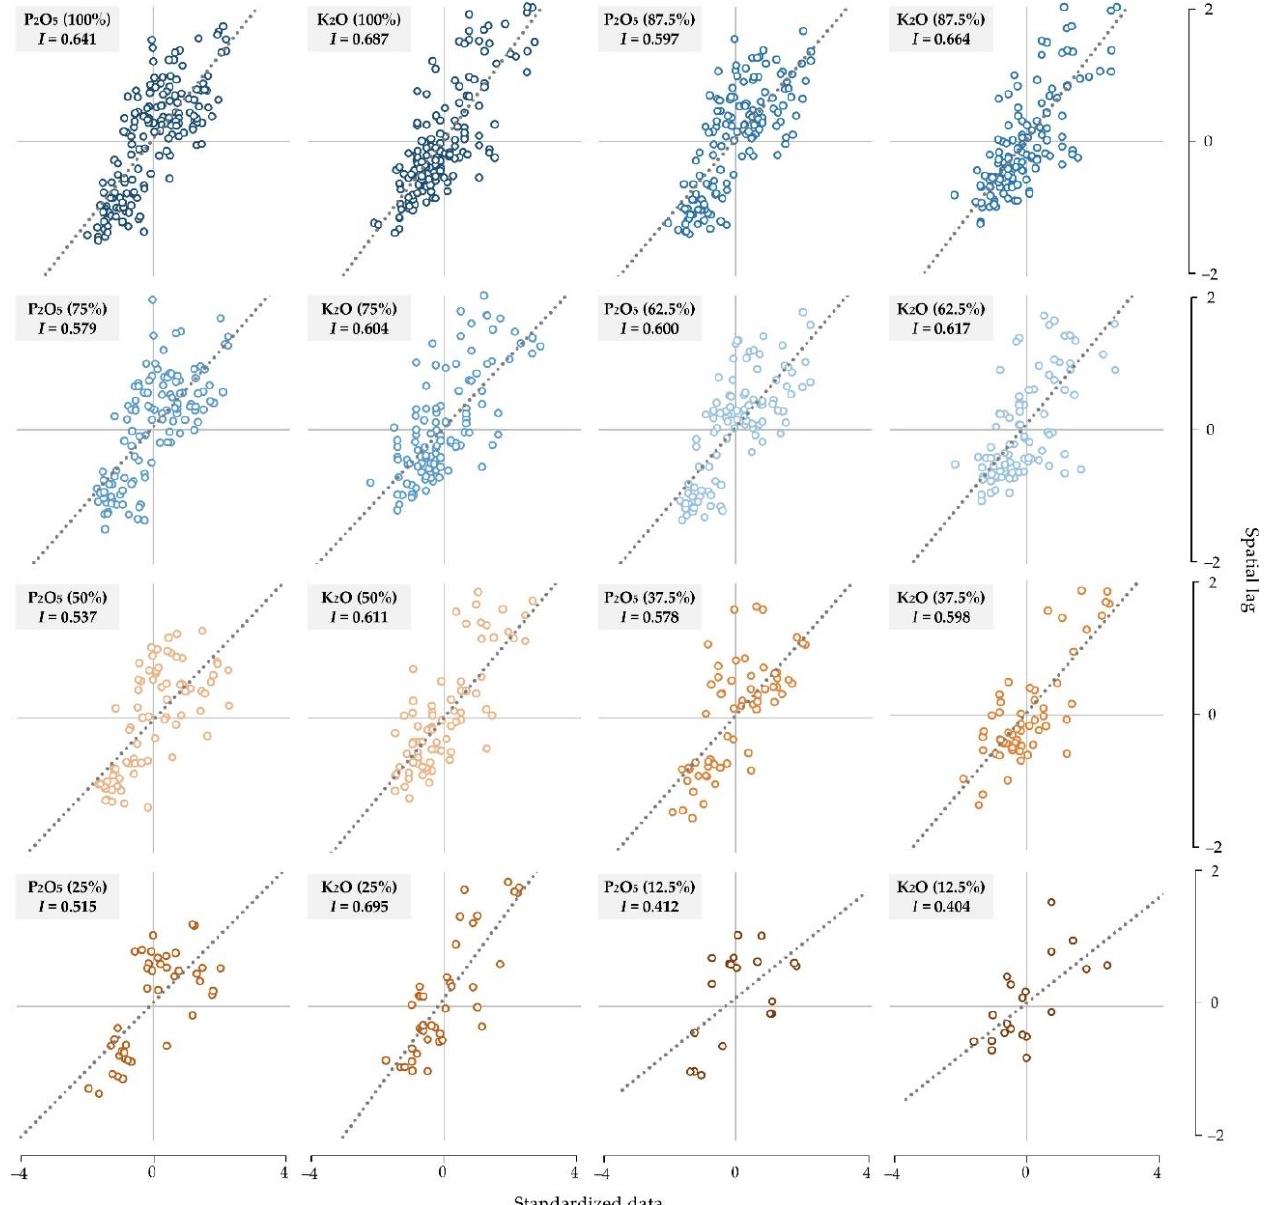
Moran’s I values of all subsets revealed a positive, moderately-high spatial autocorre- lation (Figure 4). A stable Moran’s I was retained while lowering soil sample percentages by up to 25% of the original datasets, the values dropping noticeably for the 12.5% subset. Both soil chemical properties resulted in values of over 0.500 for these subsets, while K 2 O resulted in a slightly higher spatial autocorrelation than P 2 O 5 values. The distance of the spatial autocorrelation per subset was analyzed by correlograms, showing stable value and a noticeable increase for the 25% and 12.5% subsets (Appendix A, Figure A1).